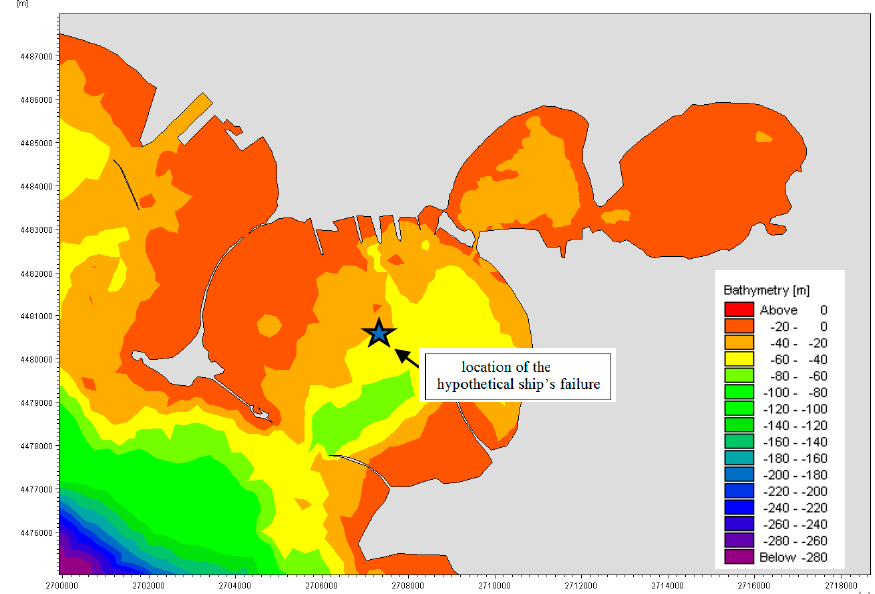
Figure 7. Computation domain used for the numerical simulations. The location of the hypothetical ship’s failure is also shown. UTM coordinates used.